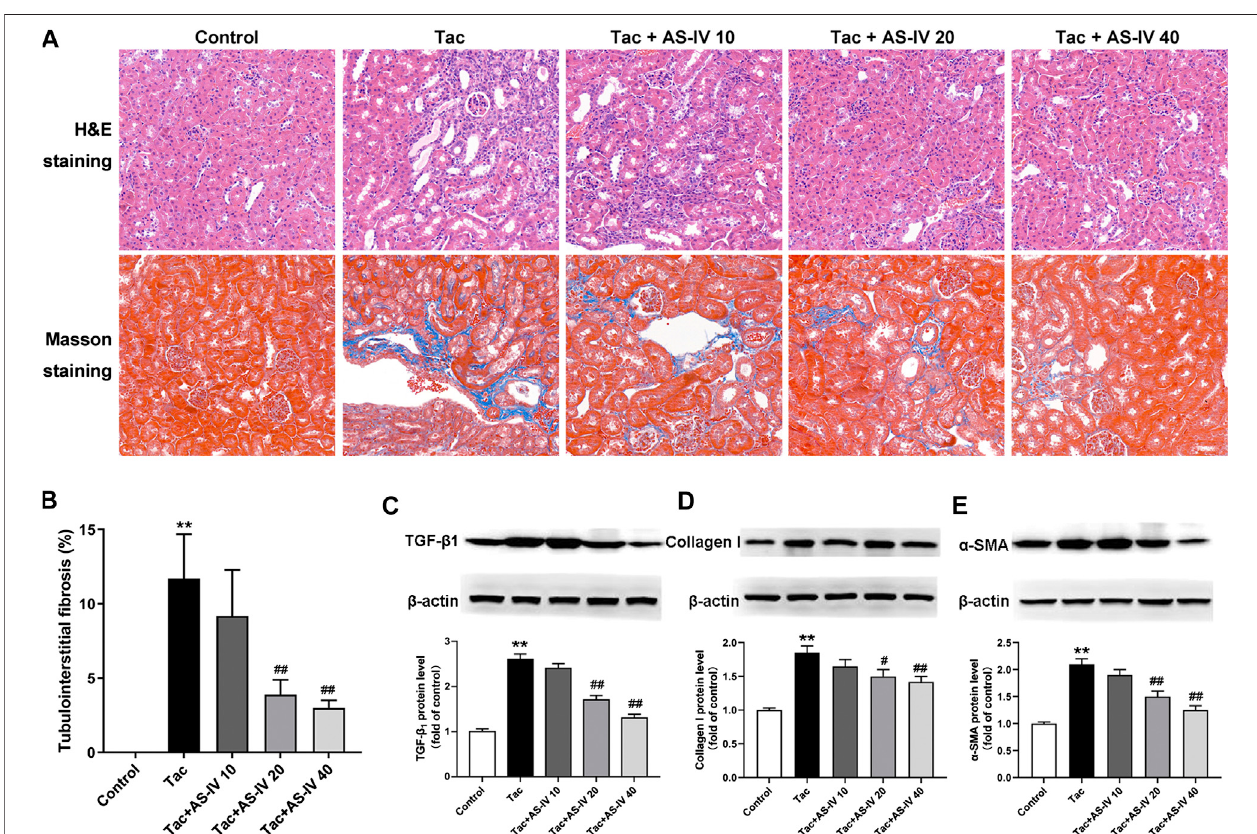
FIGURE 1 | The protective effects of Astragaloside IV from tacrolimus-induced chronic nephrotoxicity in vivo ( n (cid:1) 8) (A) Representative images of HE and Masson staining of renal tissues in mice treated with tacrolimus ± Astragaloside IV for 4 weeks (B) Quantitative analysis of the ratio of tubulointerstitial fi brosis in Masson-stained tissues (C) – (E) Representative immunoblot image and its quanti fi cation of transforming growth factor β 1 (TGF- β 1 ), Collagen I and α -smooth muscle actin ( α -SMA) in the kidney. ** p < 0.01 vs. the Control group; # p < 0.05 and ## p < 0.01 vs. the Tac group.